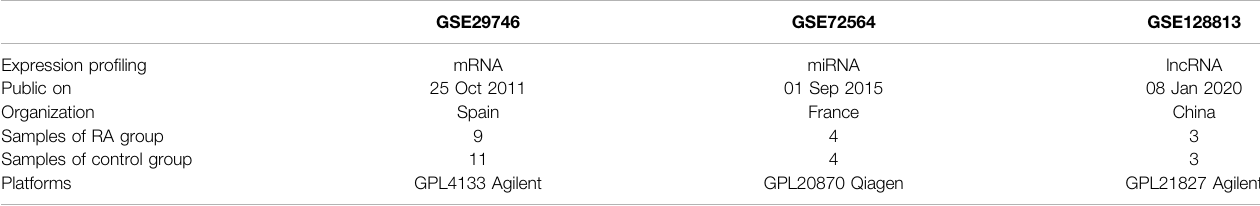
TABLE 1 | Details of the 3 human microarray